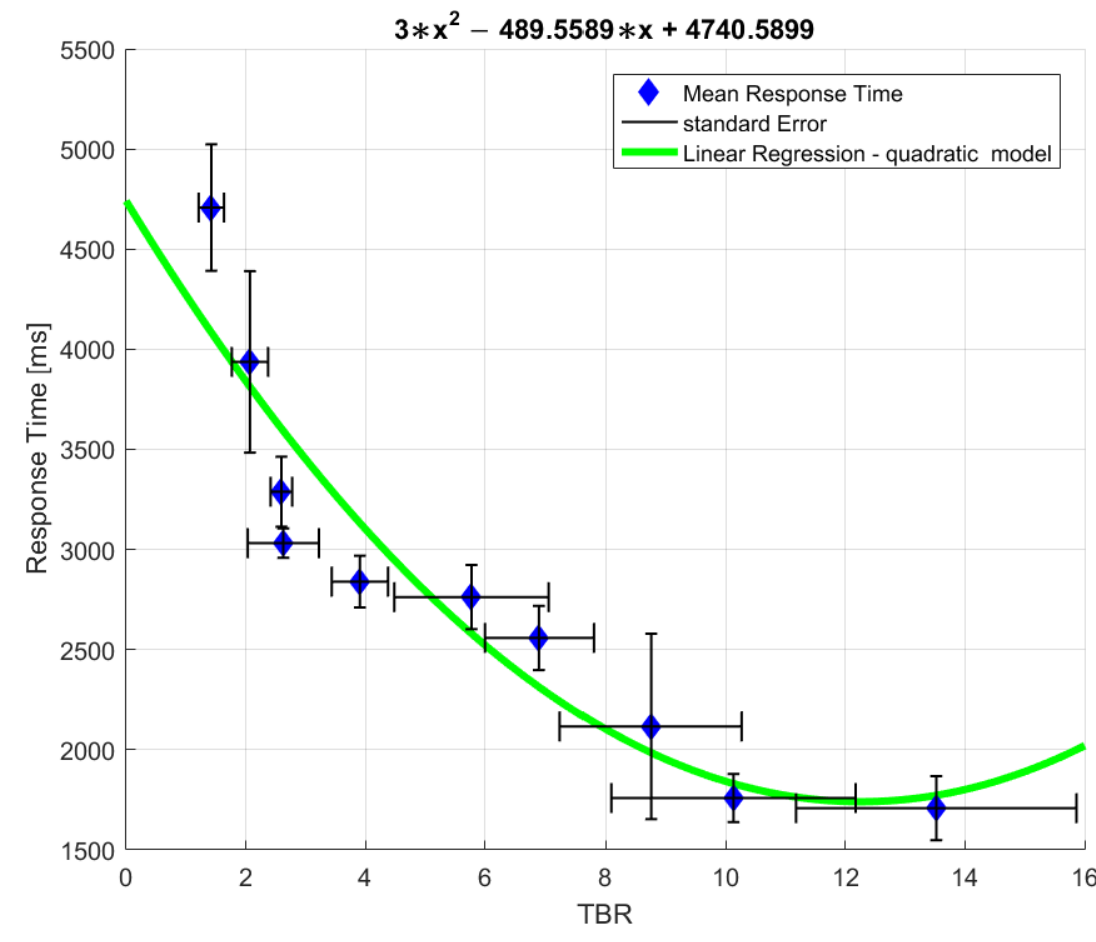
Figure 2. Quadratic regression model.